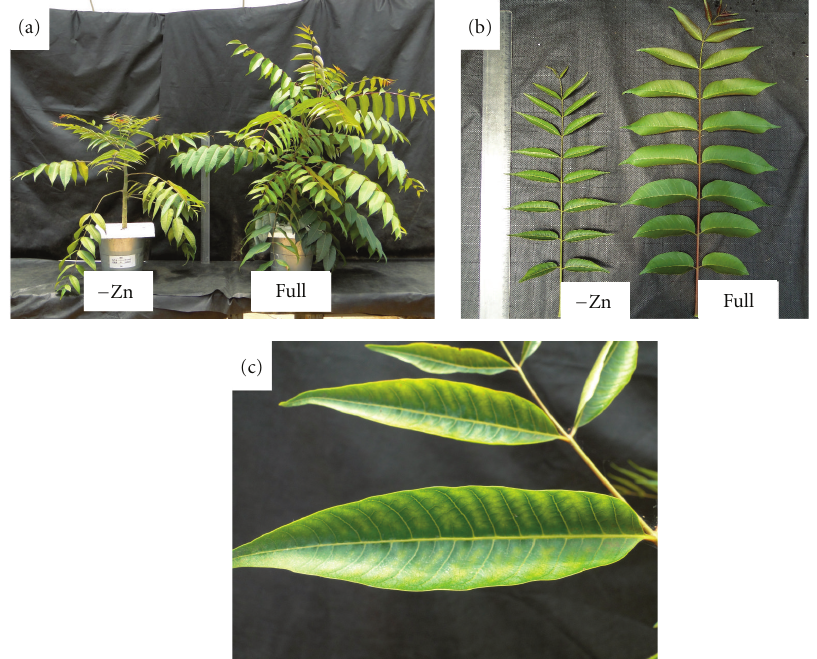
Figure 8: Symptoms of Zn deficiency on Australian Red Cedar seedlings. Fall of leaflets and smaller size of the plant (a), lanceolate leaf (b) interveinal chlorosis